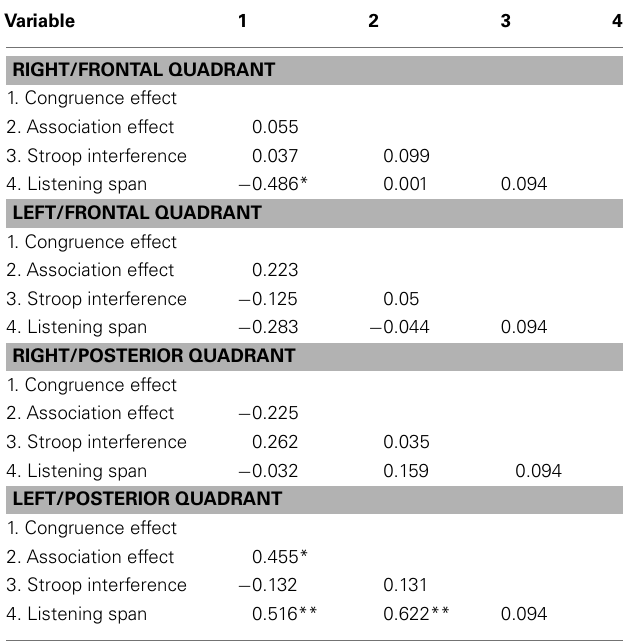
Table 4 | Results of the correlation